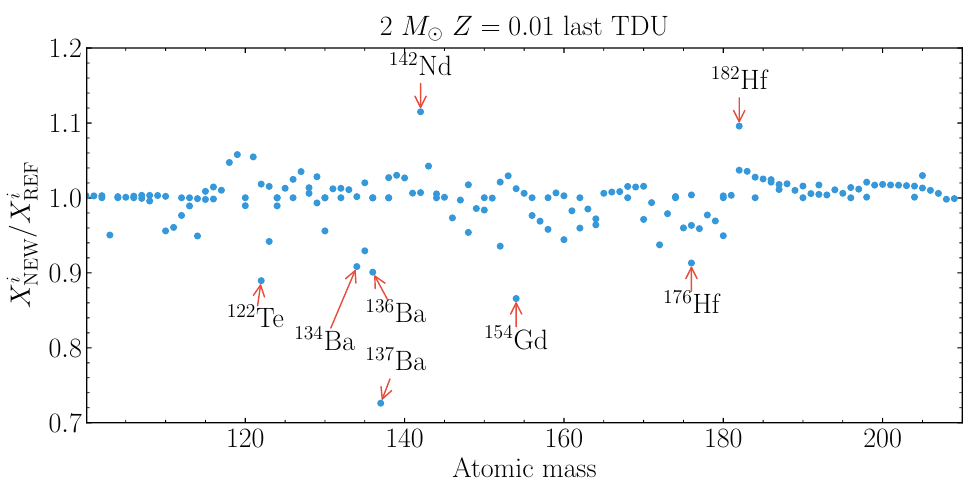
Figure 3. Same as Figure 1, but for a star with metallicity Z =